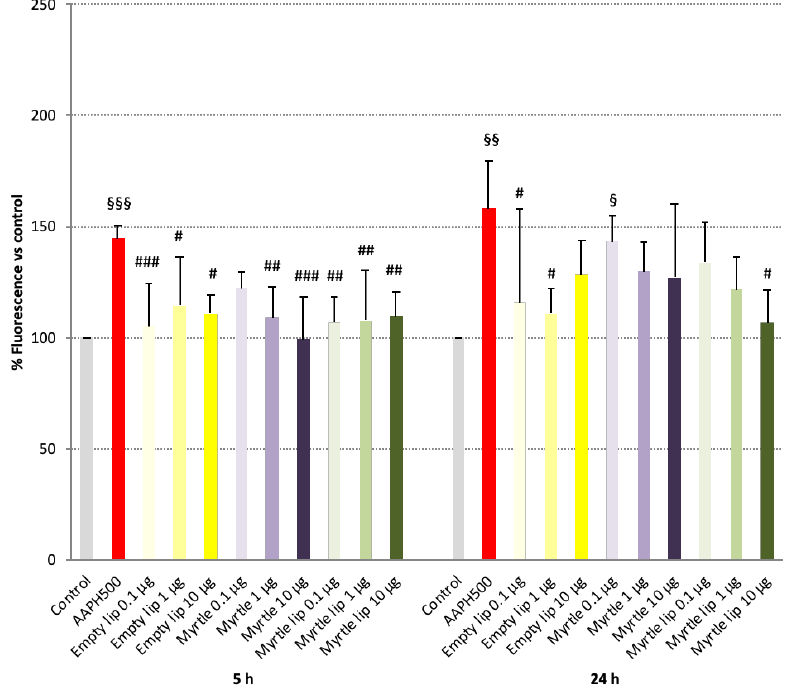
Figure 4. Effects of 500 μM AAPH, empty liposomes, myrtle solution, and myrtle liposomes on ROS production in 3T3-L1 cells after 5 and 24 h of incubation. Data are expressed as means ± SD; n = 3. # p < 0.05 vs. 500 μM AAPH; ## p < 0.01 vs. 500 μM AAPH; ### p < 0.005 vs. 500 μM AAPH; § p < 0.05 vs. control (i.e., cells without AAPH); §§ p < 0.01 vs. control; §§§ p < 0.005 vs. control.